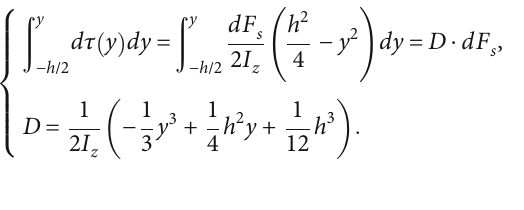
, (d – f) h , and (g – i) h fill s